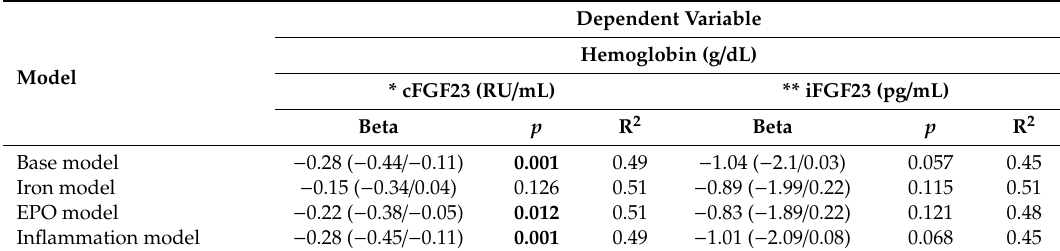
Table 3. Influence of cFGF23 and iFGF23 on hemoglobin after adjusting for biomarkers of iron metabolism, EPO concentrations and inflammation biomarkers.